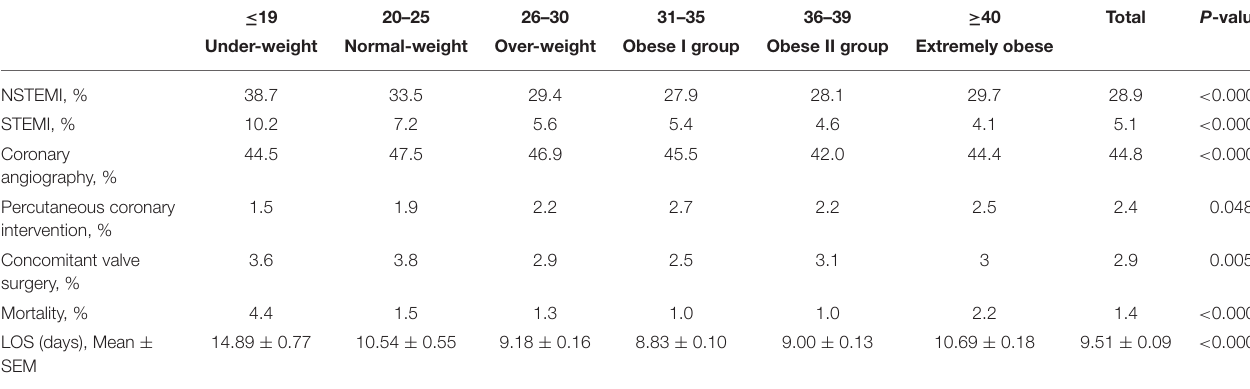
TABLE 2 | Frequency distribution of clinical course and outcomes by BMI group.